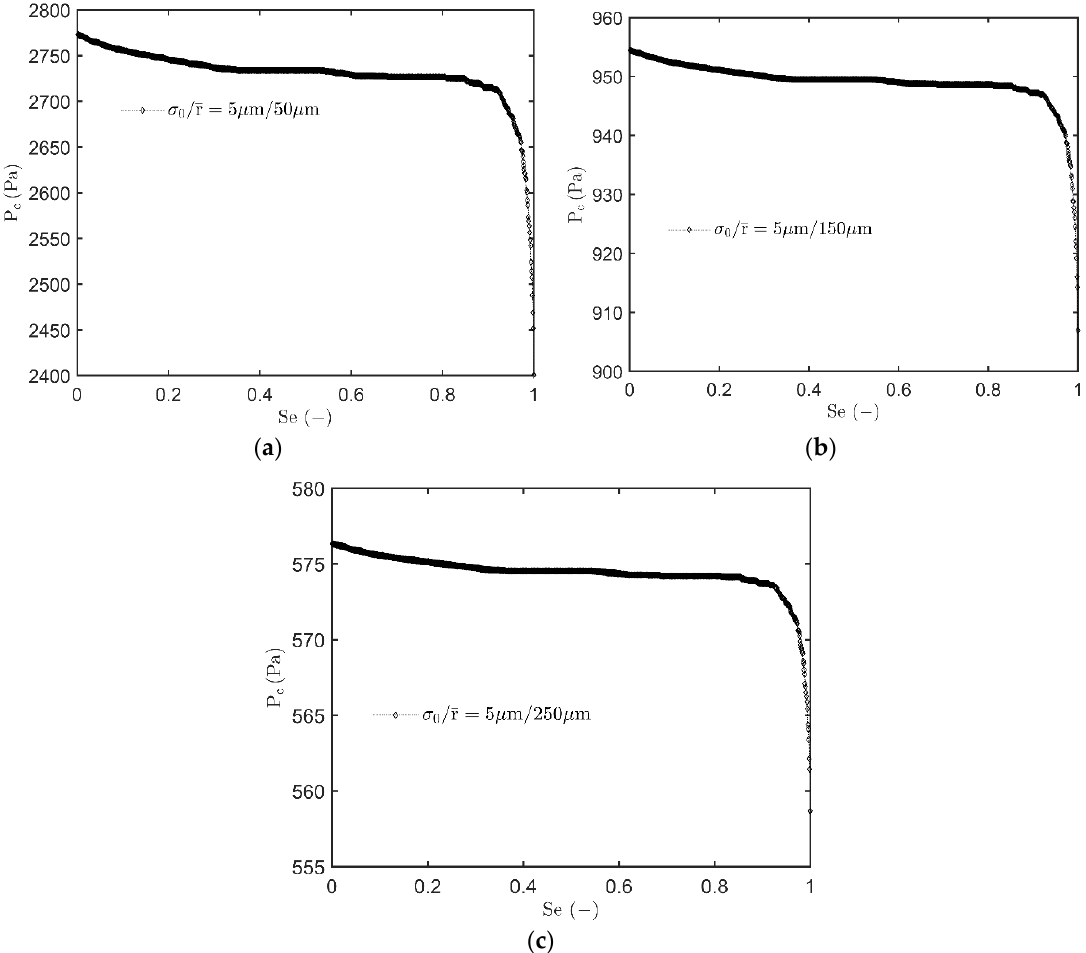
Figure 7. Influence of the mean radius on capillary pressure profile with effective saturation: ( a ) 𝜎 0 /𝑟 ̅ = 5/50 (µm), ( b ) 𝜎 0 /𝑟 ̅ = 5/150 (µm) and ( c ) 𝜎 0 /𝑟 ̅ = 5/250 (µm). The network connectivity is 6. The simulation values are averaged over 40 realizations.